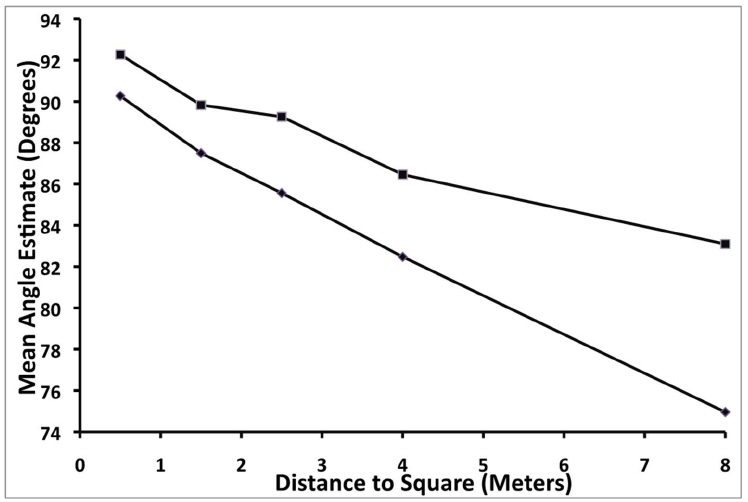
Figure 4. Mean angle estimate (in degrees) as a function of distance from the observer to each square (in meters) and location of angle within a square in Experiment 2. Diamonds (bottom line) indicate mean angle estimates for near angles and squares (top line) indicate mean angle estimates for far angles within a square. Table 2. Means and standard errors (in parentheses) for angles estimates as a function of distance both overall and separately for near vs. far location.